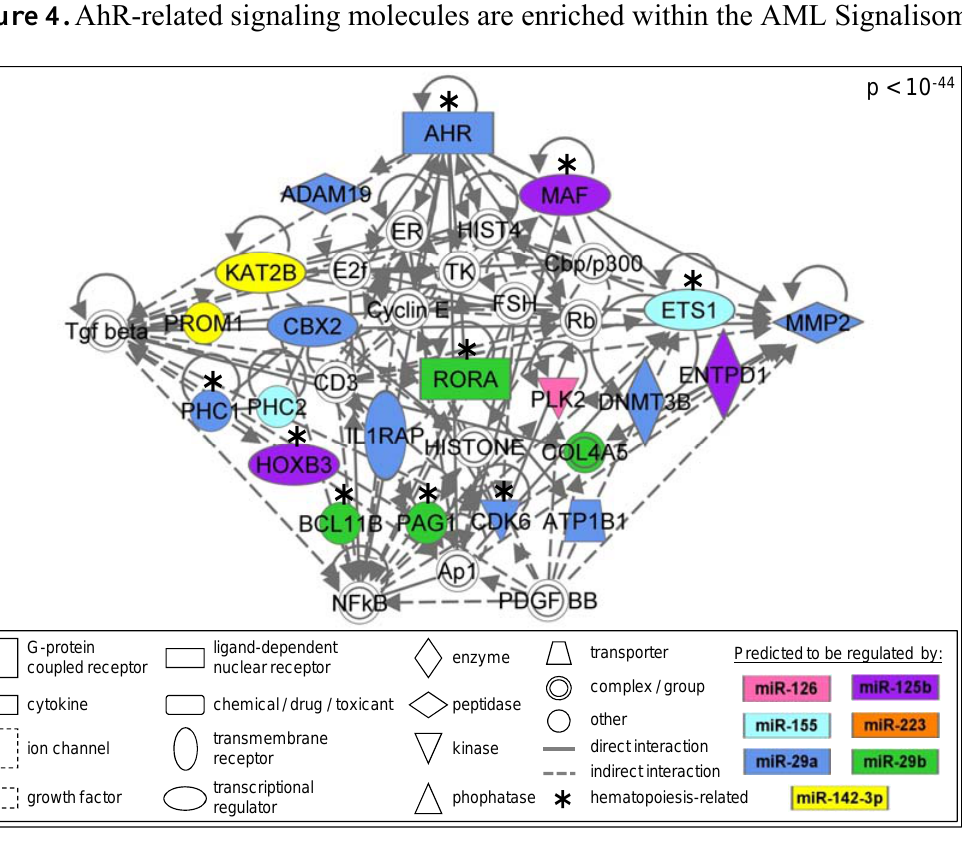
Figure 4. AhR-related signaling molecules are enriched within the AML